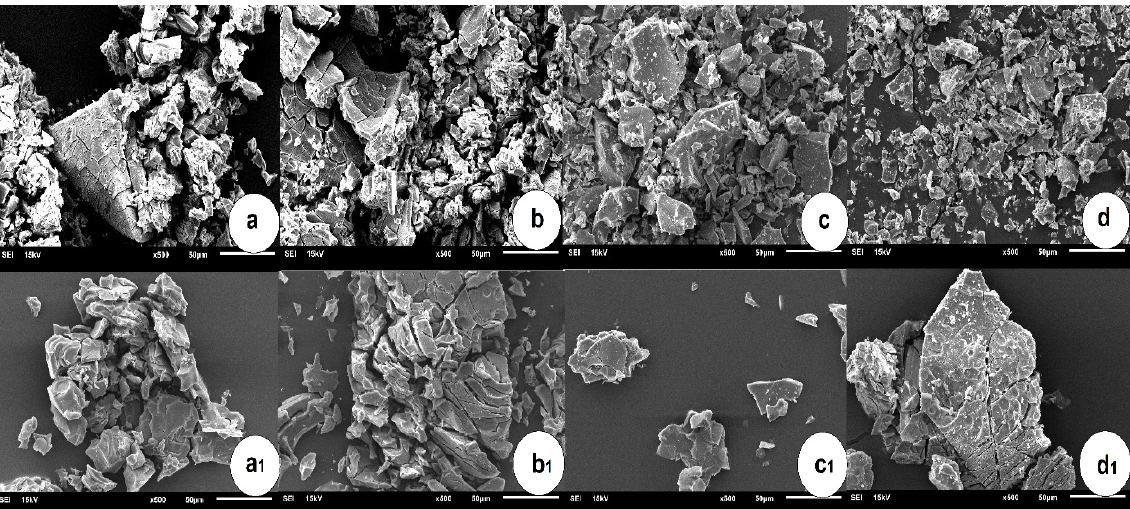
Figure 8. SEM images of produced catalysts. ( a ) SiPc/TiO 2 , ( b ) ZnPc/TiO 2 , ( c ) CuPc/TiO 2 and ( d ) CoPc/TiO 2 without TX-100 and ( a 1 ) SiPc/TiO 2 , ( b 1 ) ZnPc/TiO 2 , ( c 1 ) CuPc/TiO 2 and ( d 1 ) CoPc/TiO 2 with TX-100.